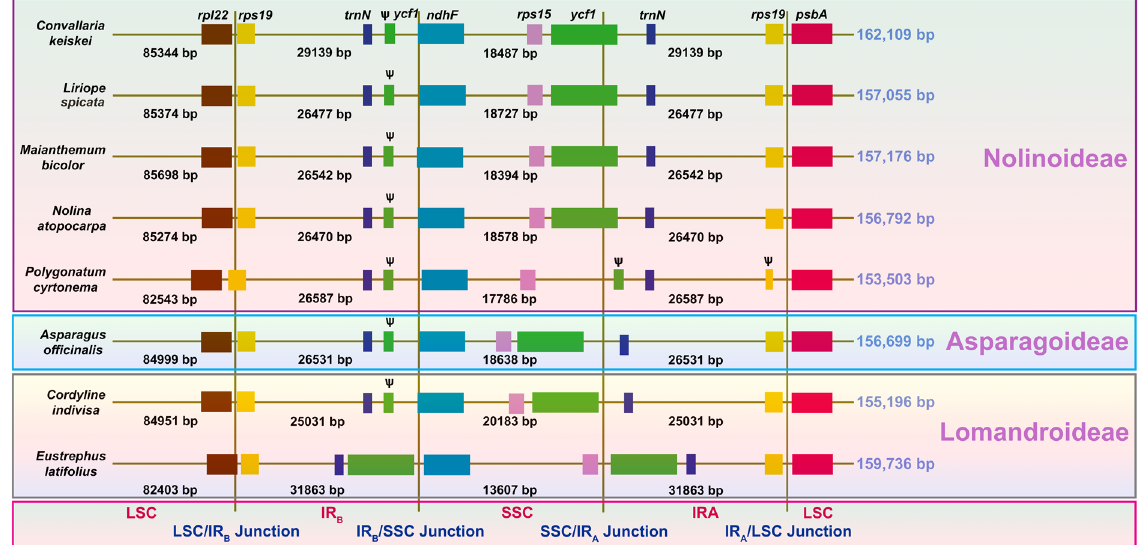
Figure 1. Comparison of the large single-copy (LSC), small single-copy (SSC) and inverted repeat (IR) border regions of Asparagaceae chloroplast genomes. Ѱ indicates a pseudogene. The figure is not drawn to